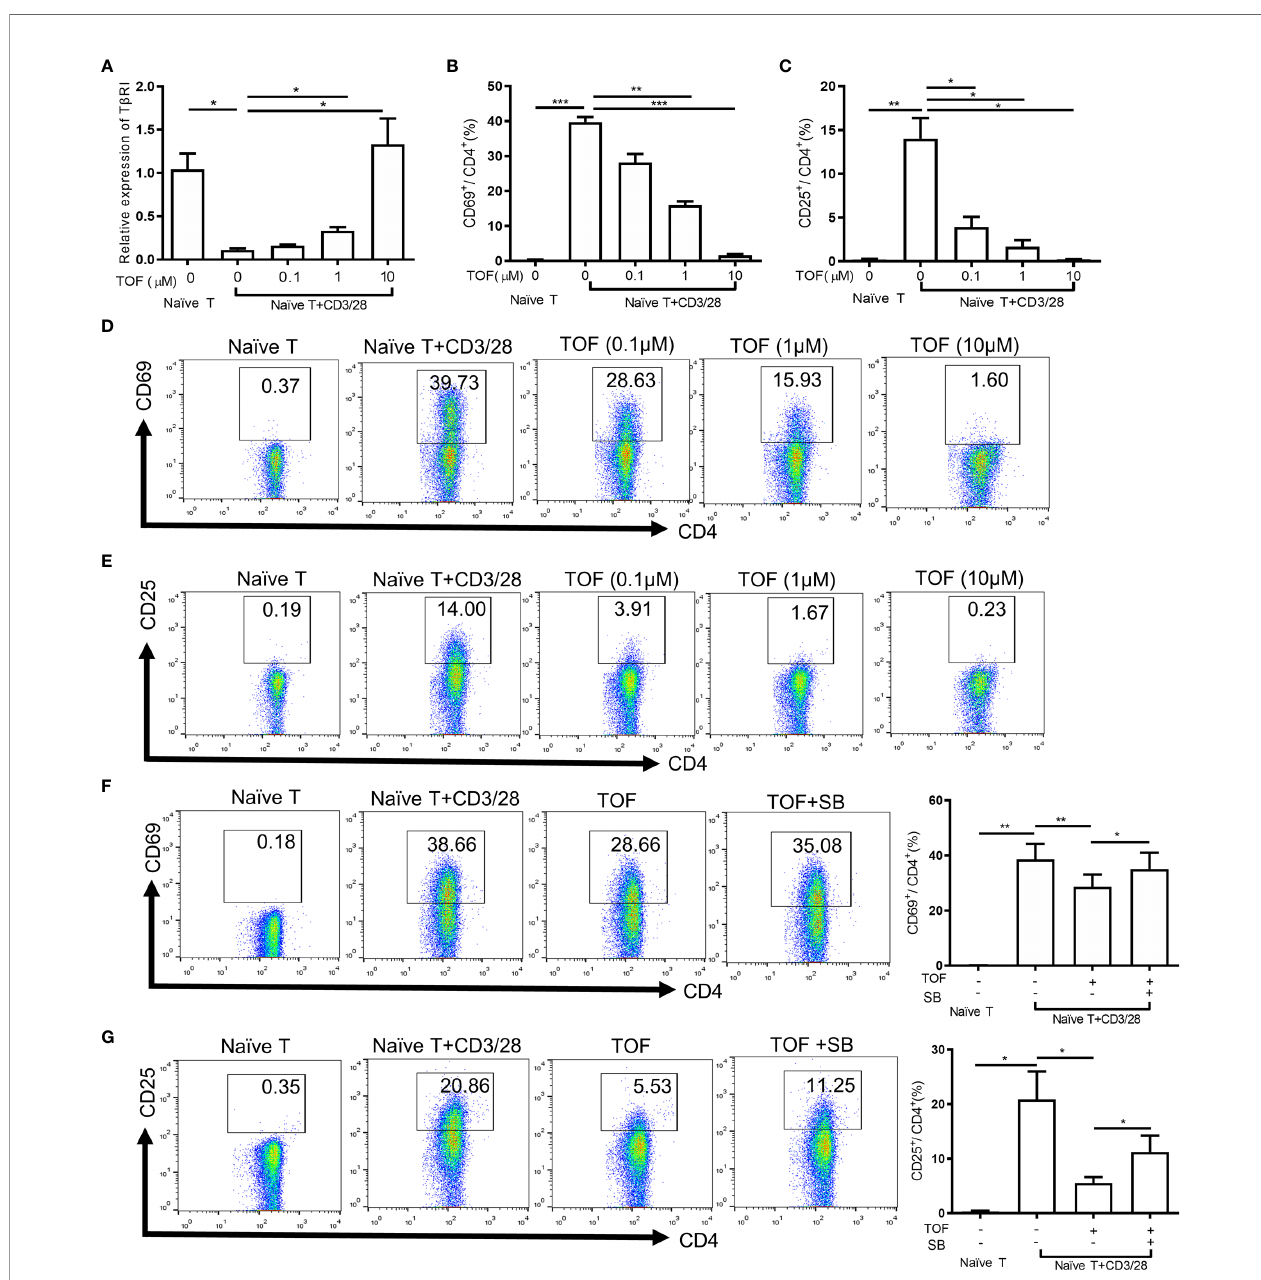
FIGURE 3 | Tofacitinib inhibits the activation of CD4 + T cells by increasing TGF b RI expression in vitro . Naïve CD4 + T cells from PBMCs of SLE patients (n = 4) were stimulated with anti-CD3/CD28 beads in the absence or presence of TOF (0.1-10 µM) for 24 h. (A) TGF b RI (T b RI) mRNA level (n = 4) in naïve CD4 + cells was analyzed. (B, D) The percentages of active CD4 + T cells (CD4 + CD69 + T cells) (n = 4) were determined. (C, E) The percentages of active CD4 + T cells (CD4 + CD25 + T cells) (n = 4) were determined. Puri fi ed naïve CD4 + T cells from SLE patients (n = 5) were stimulated with anti-CD3/CD28 beads in the absence or presence of TOF (0.1µM) with or without 10µM TGF b RI inhibitor SB431542. (F) The percentages of active CD4 + T cells (CD4 + CD69 + T cells) (n = 5) were determined. (G) The percentages of active CD4 + T cells (CD4 + CD25 + T cells) (n = 5) were determined. Error bars indicate SEM. * P < 0.05, ** P < 0.01, *** P < 0.001. TOF, tofacitinib; SB,